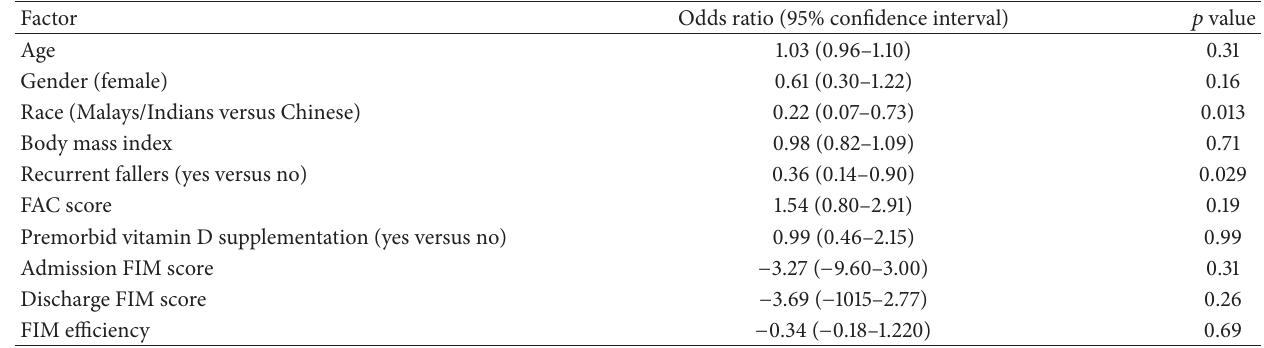
Table 3: Univariate analysis of factors associated with vitamin D deficiency.